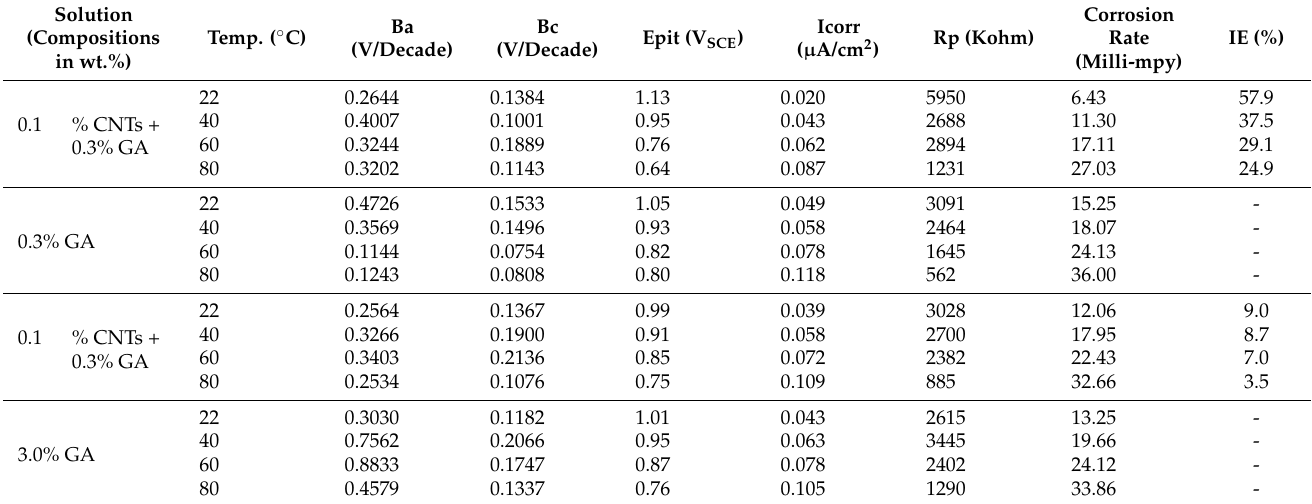
Table 5. Polarization parameters for 316 L stainless steel tested in CNTs nanofluids and GA solutions at different tempera-